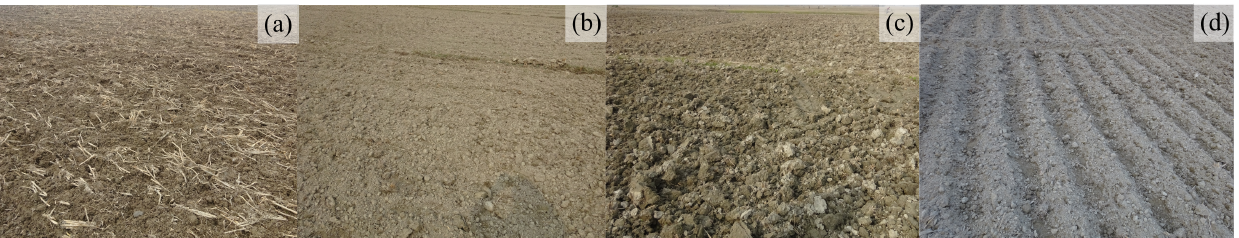
Figure 4. Field photographs to illustrate the surface roughness conditions in different agricultural plots on the Kosi Fan. ( a ) shows the photograph of a stubble field (s < 1 cm), ( b ) harrow field (1 cm ≤ s < 2 cm), ( c ) ploughed field (2 cm ≤ s < 3.5 cm), and ( d ) furrow field (s ≥ 3.5